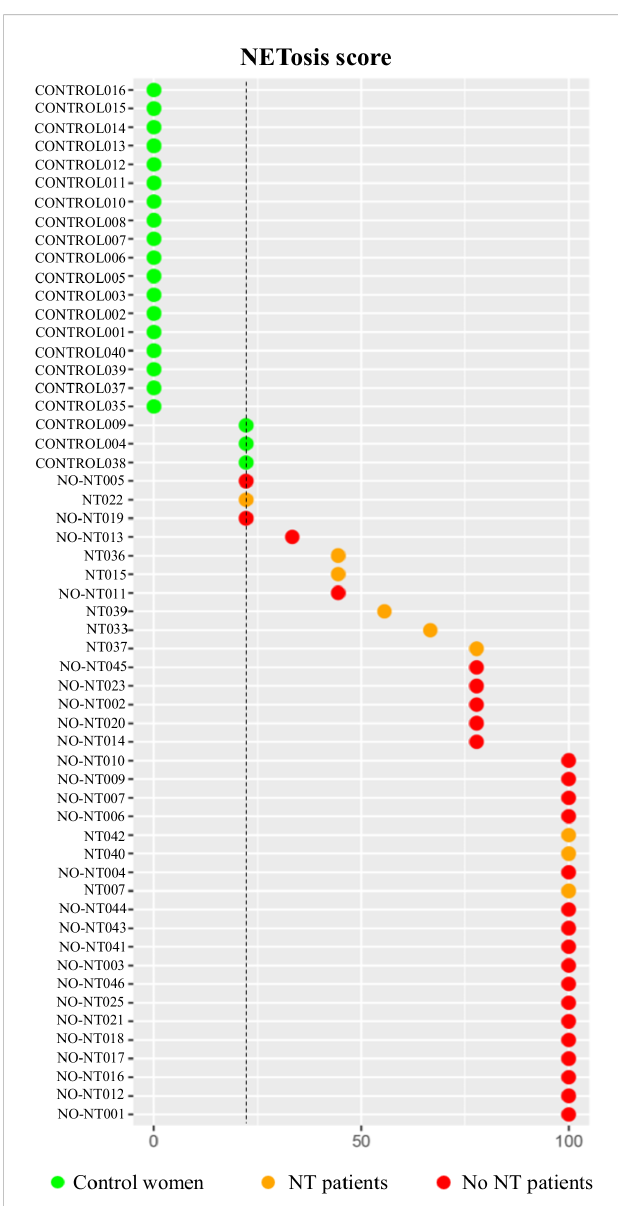
FIGURE 6 NETosis score values of patients with high-grade serous ovarian cancer (HGSOC) without neoadjuvant treatment (NT) (n=9), with NT (n=26) and control women (n=21). Vertical line represents the NETosis score value (23%) that best allows to differentiate between HGSOC patients and control women. NT, noeadjuvant treatment. p